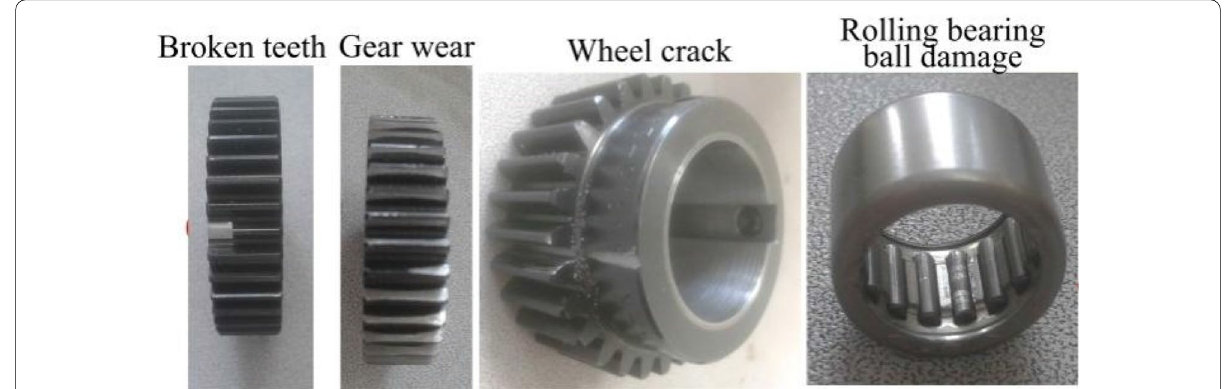
Figure 7 Parts failure of